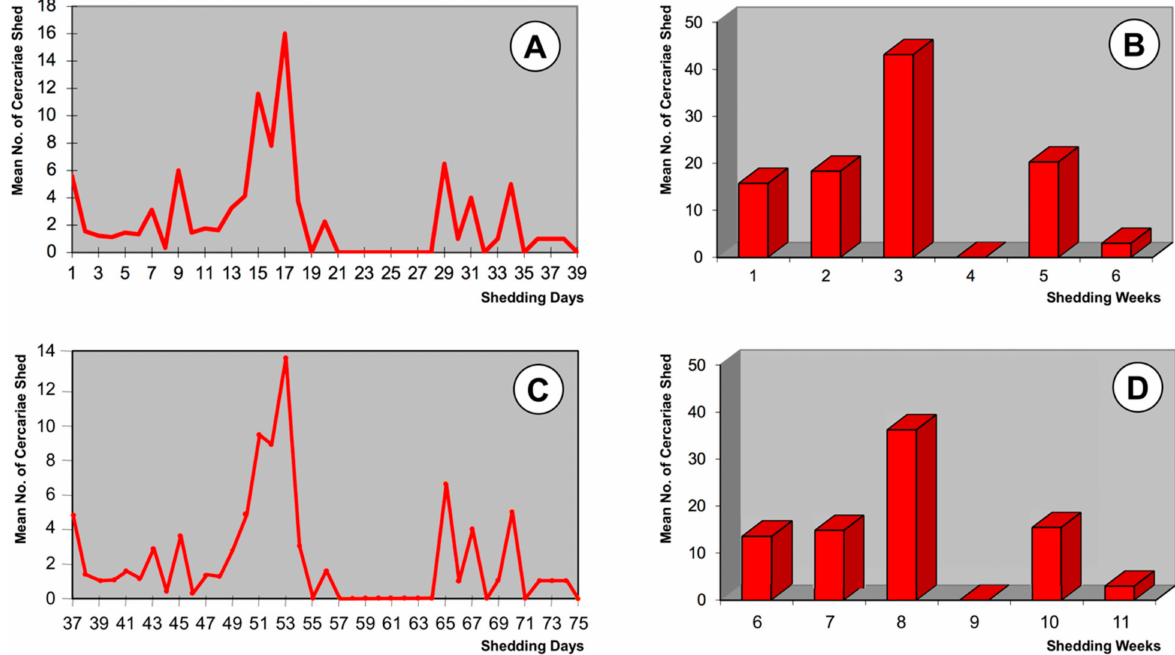
Figure 5. Chronobiological patterns of cercarial emergence by Galba truncatula from the Northern Bolivian Altiplano monomiracidially infected with the llama isolate of Fasciola hepatica from the Argentine high Andean plateau: ( A , B ) shedding period analyzed according to the mean amounts of cercariae shed daily and weekly from the day of the emergence of the first cercaria by each snail; ( C , D ) shedding period analyzed according to the mean amounts of cercariae shed daily and weekly from the day of the miracidial infection; prepatent period not shown.